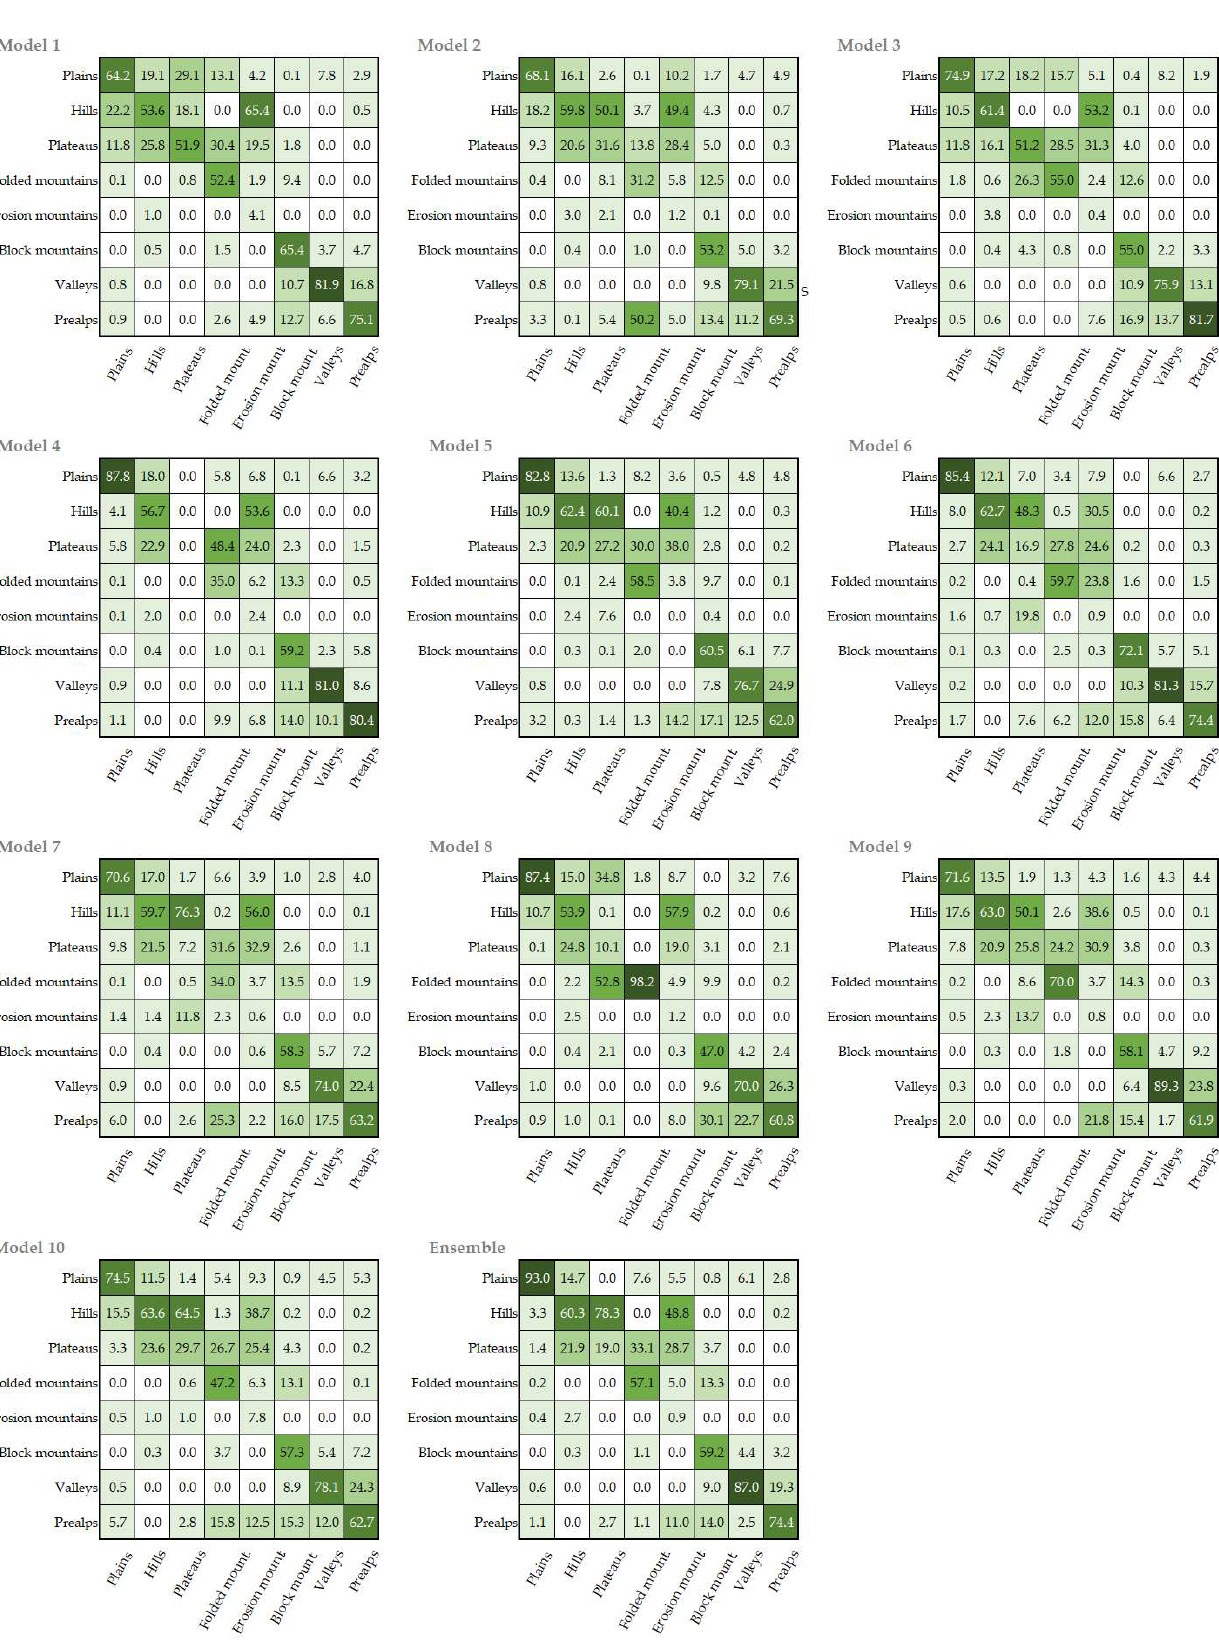
Figure 7. Confusion matrices for all the models and the ensemble (%). The darker the background of a cell, the higher the value it represents.